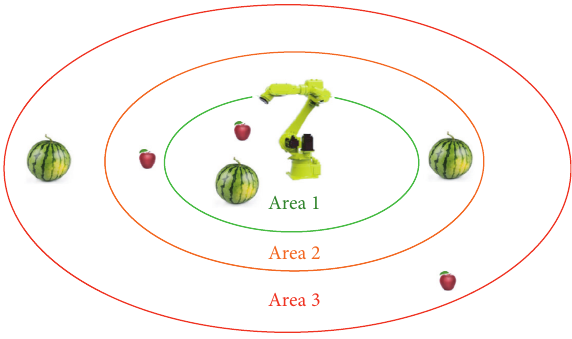
Figure 15: Grab the object area diagram.